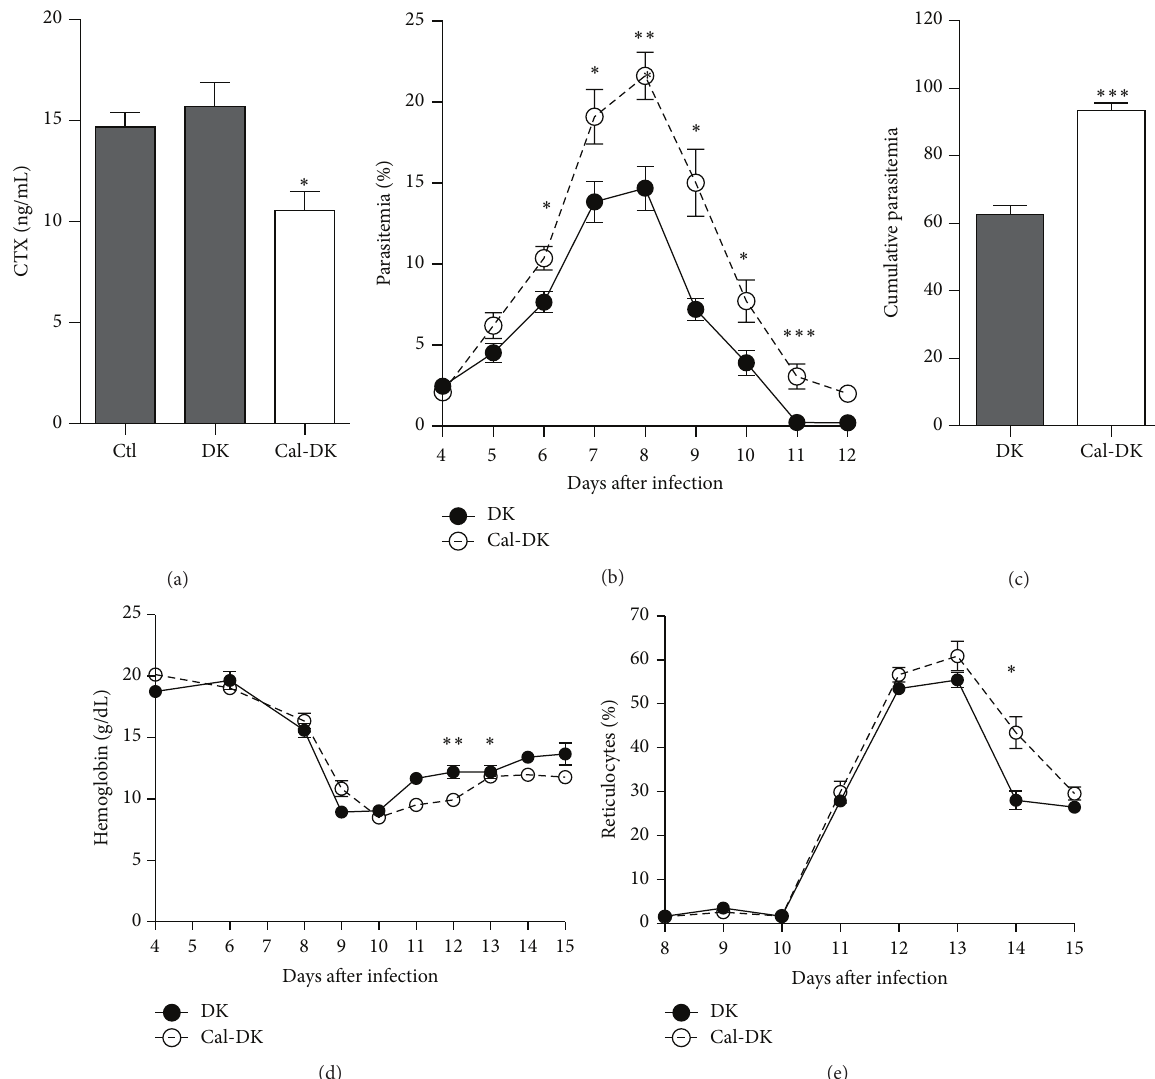
Figure 1: Impact of calcitonin on Plasmodium chabaudi adami parasitemia and anemia. Mice were treated with calcitonin (Cal-DK) or PBS (Ctl and DK) during 5 consecutive days. P. c. adami DK parasites (10 5 pRBCs) were inoculated on the 3rd day of treatment. Four mice of each infectedgroupand4uninfectedcontrolsweresacrificedat5dayafterinfectionandC-telopeptideoftypeIcollagen(CTX)levelswereassessed in the plasma by ELISA (a). Parasitemia was monitored daily for determination of the kinetics of infection (b) and cumulative parasitemia (c). Hemoglobin levels (d) and reticulocytosis (e) were measured in the blood. Data are mean ± SEM and represent the compilation of three experiments (a total of 14–18 mice per infected group); values are compared using a nonparametric Student’s 𝑡 -test. ∗ 𝑃 < 0.05 ; ∗∗ 𝑃 < 0.01 ; ∗∗∗ 𝑃 < 0.001